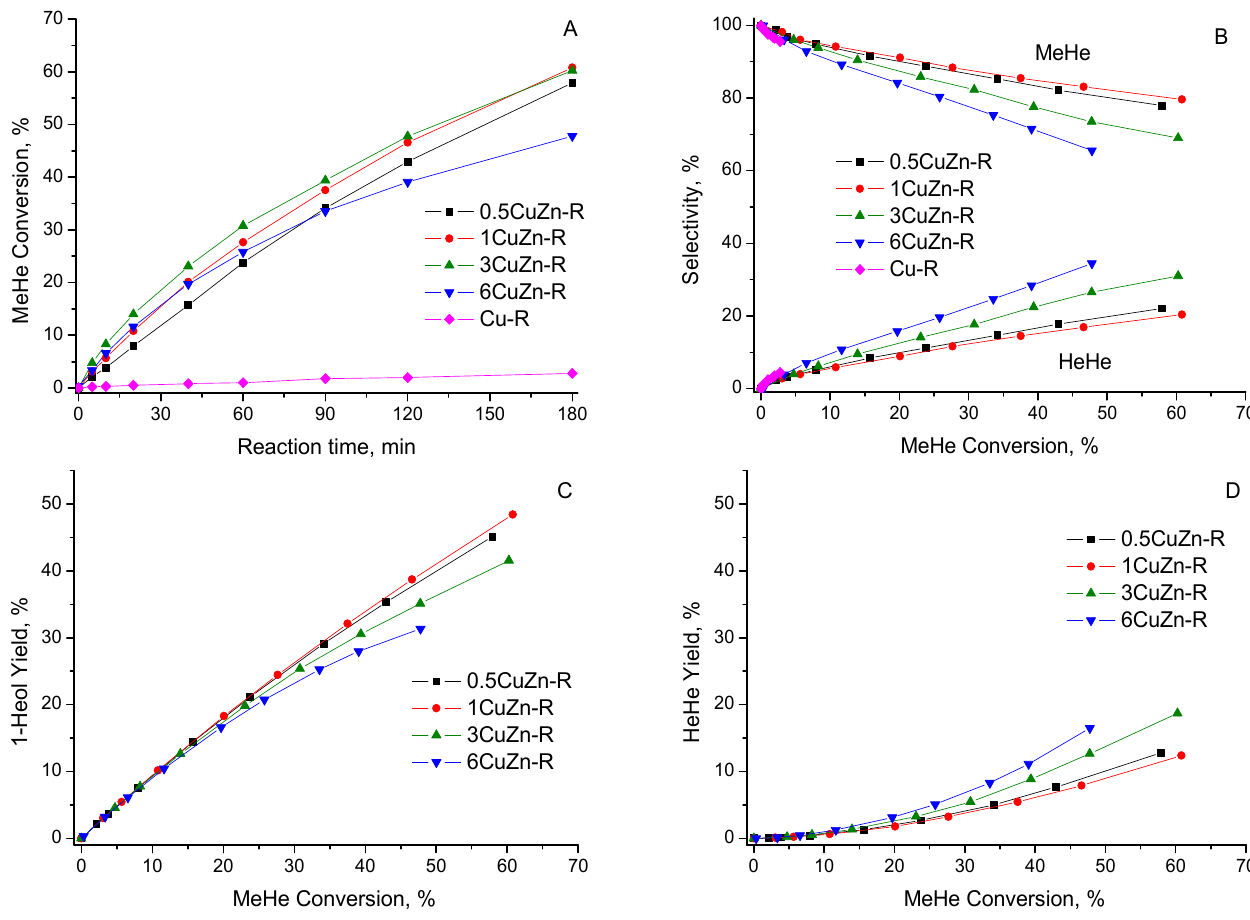
Figure 4. ( A )—Methyl hexanoate (MeHe) conversion in dependence on reaction time for catalysts with different Cu/Zn ratio. ( B )—selectivity to hexan-1-ol (1-Heol) and hexyl hexanoate (HeHe) in dependence on MeHe conversion. ( C )—The yield of 1-Heol in dependence on MeHe conversion. ( D )—The yield of HeHe in dependence on MeHe conversion. Catalyst weight—1.5 g, MeHe load—0.69 mol, T reac. = 210 °C, p H2 = 100 bar.